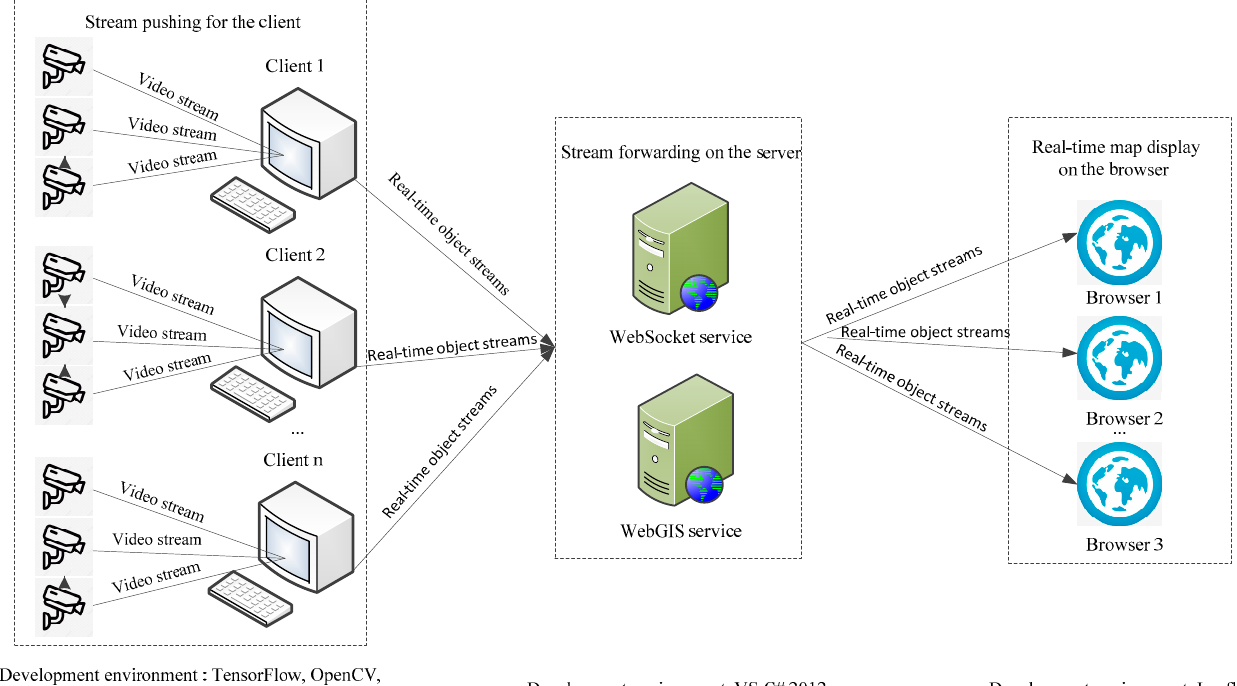
Figure 6. The video WebGIS system architecture.